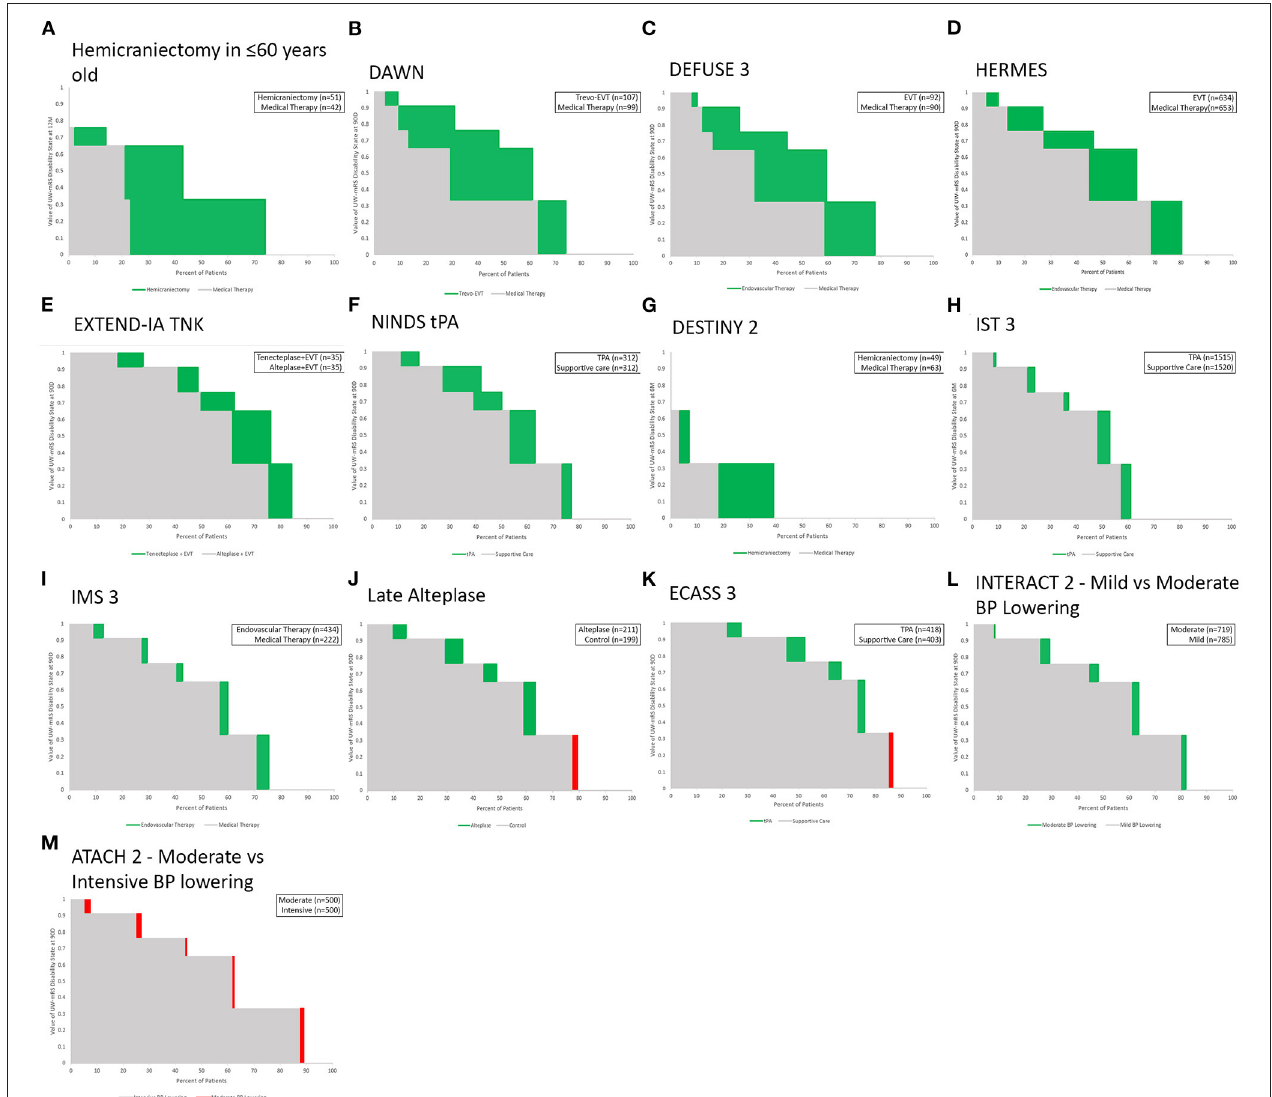
FIGURE 5 | (A–M) General comparative display of Utility Staircase plots for 13 RCTs and meta-analyses of treatments for acute ischemic and hemorrhagic stroke that used the mRS as a primary endpoint. Charts are ordered, left to right and then top to bottom, by each study’s point estimate of the active intervention’s overall magnitude of effect in increasing health-related quality of